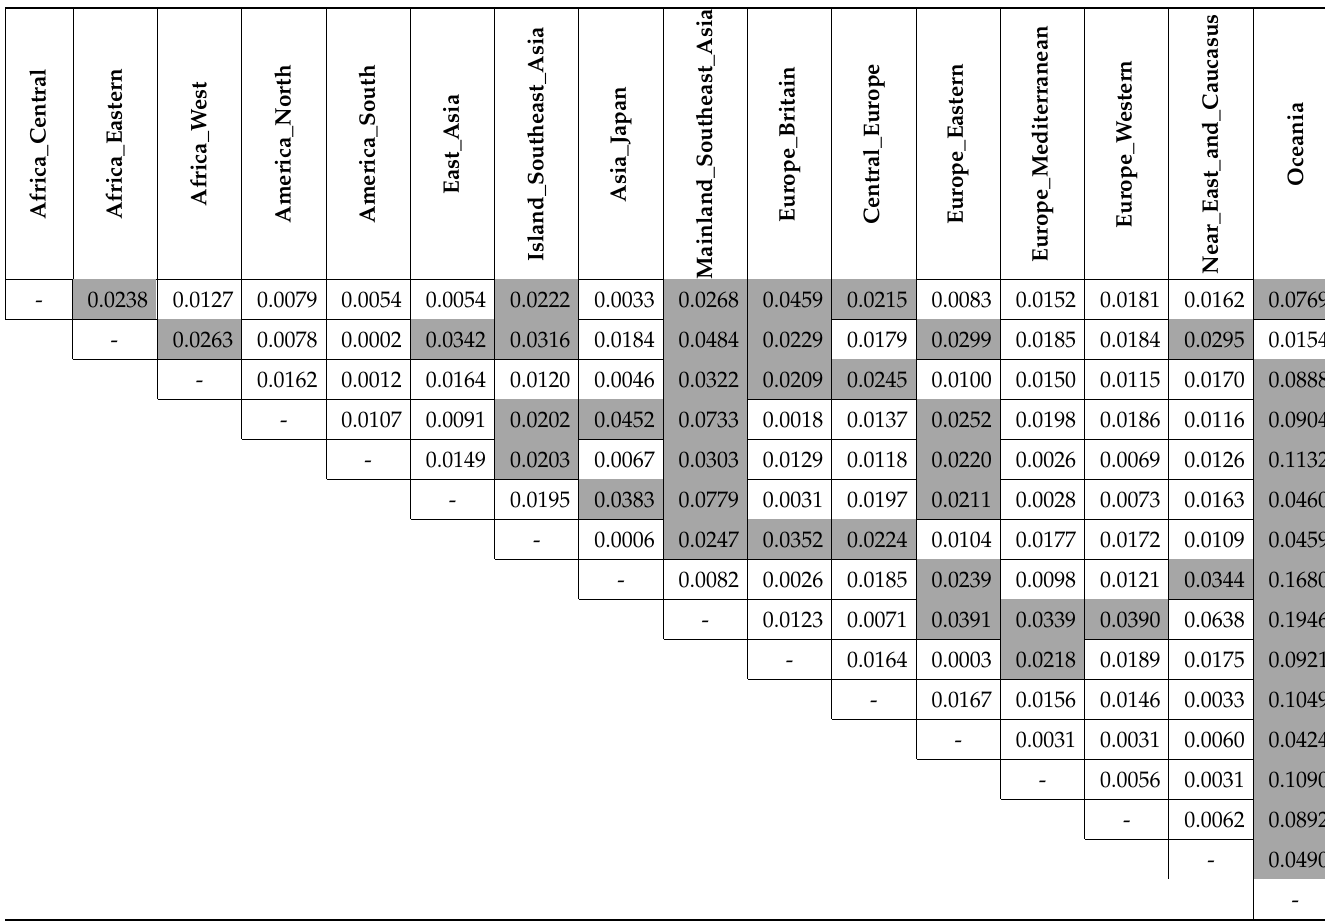
Table 3. Fst statistics calculated using DNAsp between each group of strains, categorized according to their geographical origins, using mtDNA genomic data. Values higher than 0.02 are